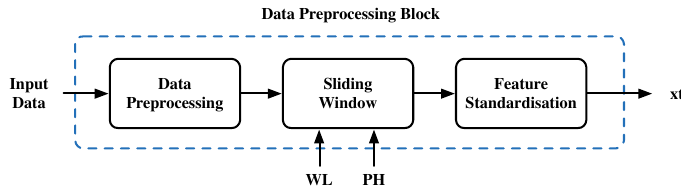
Figure 8. Data Preprocessing block. The three main actions performed in this block are shown.